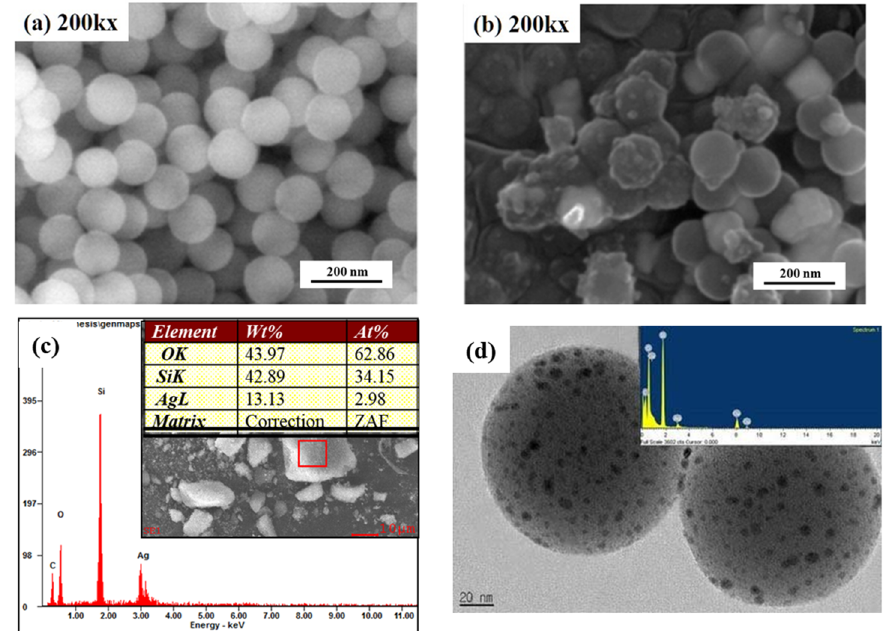
Figure 2 . The FE-SEM images of ( a ) amorphous SiO 2 and ( b ) SiO 2 @Ag; ( c ) EDX analysis of SiO 2 @Ag; ( d ) FE-TEM image of SiO 2 @Ag with EDX analysis (inset).